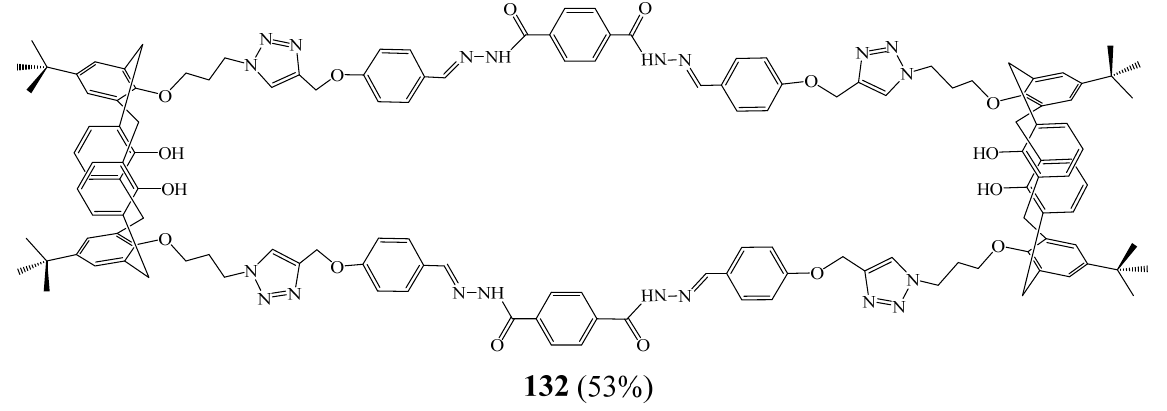
Figure 34. Structure of macrocycle 132 as selective sensor towards Cu 2+ . (Reprinted with permission from ref. [55]. Copyright 2016 Elsevier).